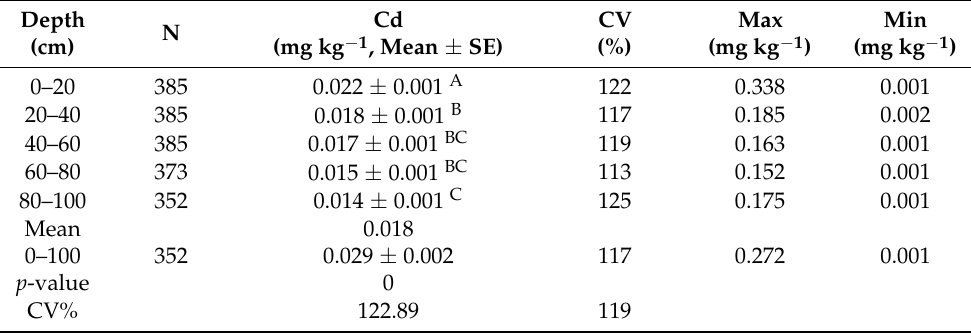
Table 3. Measured Cd concentration and its variation with